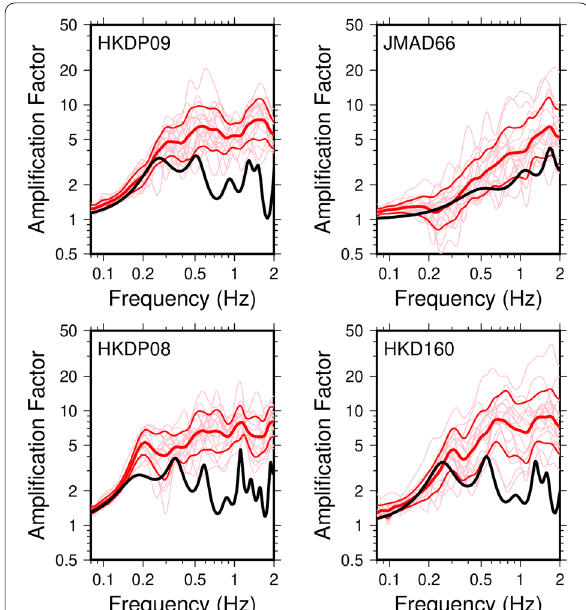
Fig. 15 Amplification factors at four sites in the Hakodate Plain. The site locations are specified in Fig. 13. Thin red lines represent the amplifications of the simulated waveforms from the basin model relative to the rock model for all numerical cases. The thick red line indicates their logarithmic mean and standard deviation. The black solid line corresponds to the theoretical amplification factor of the SH-wave with the vertical